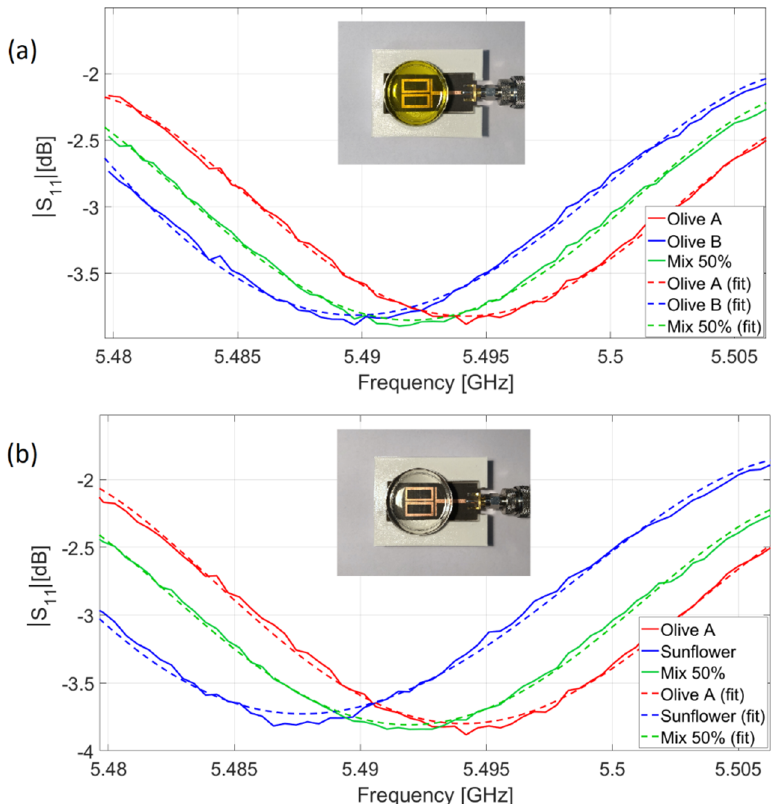
Figure 6. Modulus of the measured scattering parameter |S 11 | along with fitting curves for various oils and their mixtures: ( a ) Extra-virgin olive oil A vs. Extra-virgin olive oil B. ( b ) Extra-virgin olive oil A vs. Sunflower oil. Insets: Petri dish filled with ( a ) extra-virgin olive oil A and ( b ) sunflower oil.